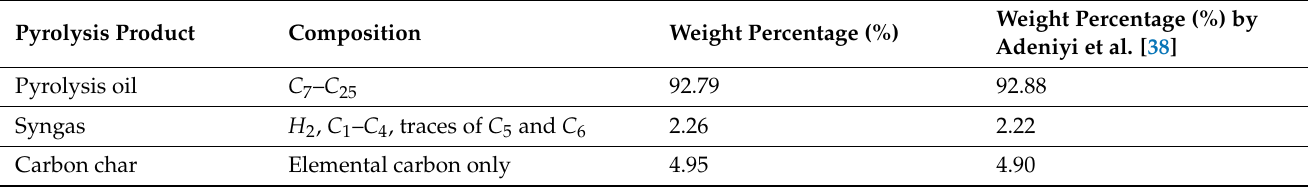
Table 2. A comparative record for the HDPE pyrolysis product distribution of this study and justified by another research